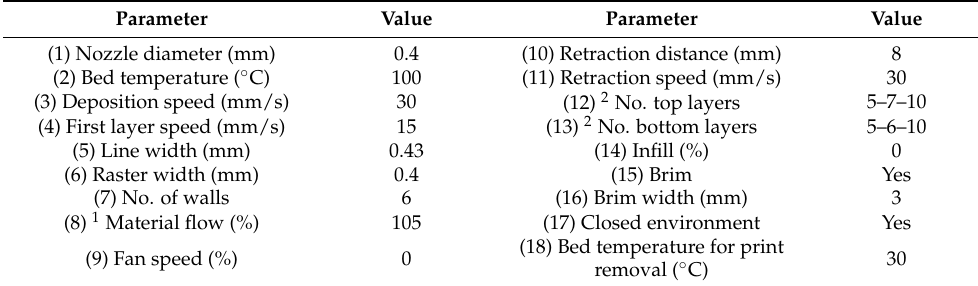
Table 2. Constant process parameters and their